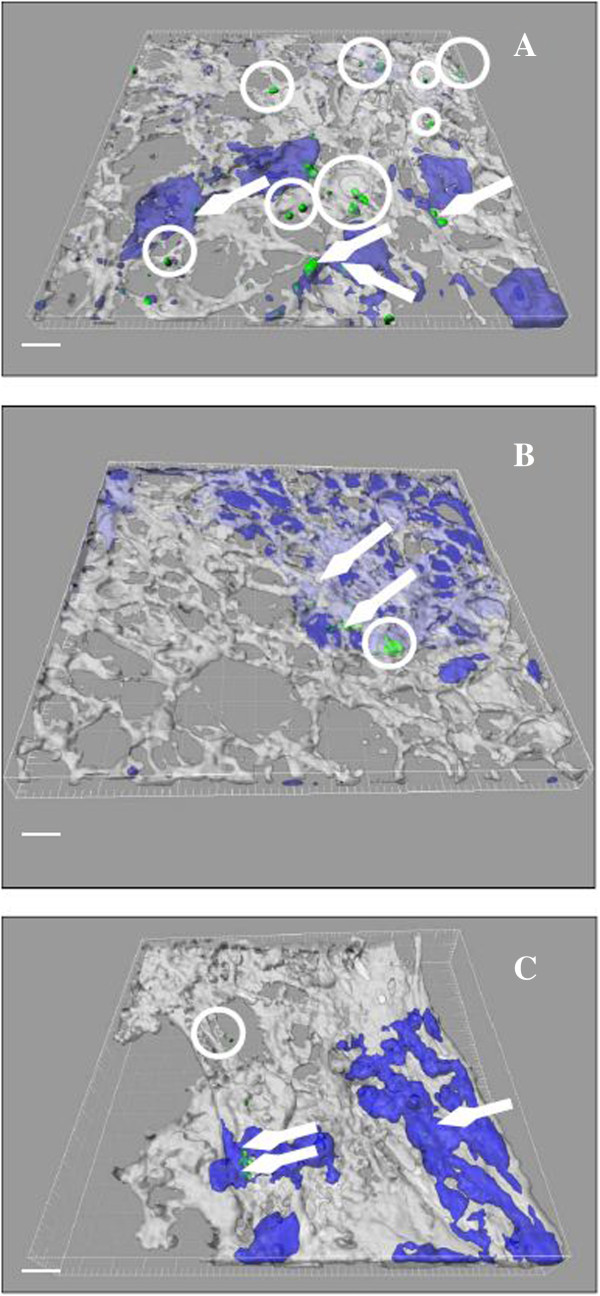
Visualisation of different NP in the basal compartment of triple cell culture model (actin, white; dendritic cells, blue; nanoparticles, green). The pictures represent 3D renderings of the complete data set and the actin as well as the dendritic cell labeling was made transparent to show intracellular nanoparticles. A) unloaded CTC NP, B)CTC pGFP NP and C)CTPPC pGFP NP. Arrow marks internalised NP into MDDC; extracellular NP are encircled. White bar represents a 20 μm scale.